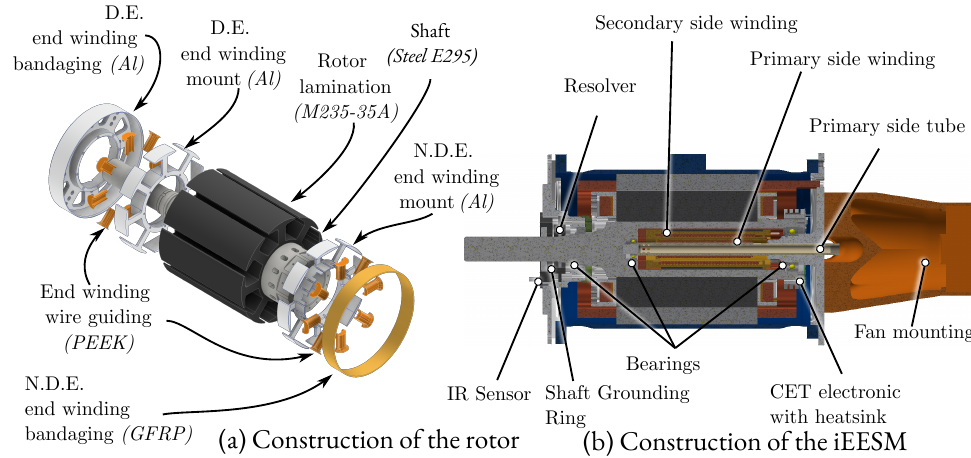
Figure 13. Mechanical design of the rotor ( a ) and the complete iEESM ( b ) in a cross-sectional view. Figure 14 shows the integration of the WPT system for the